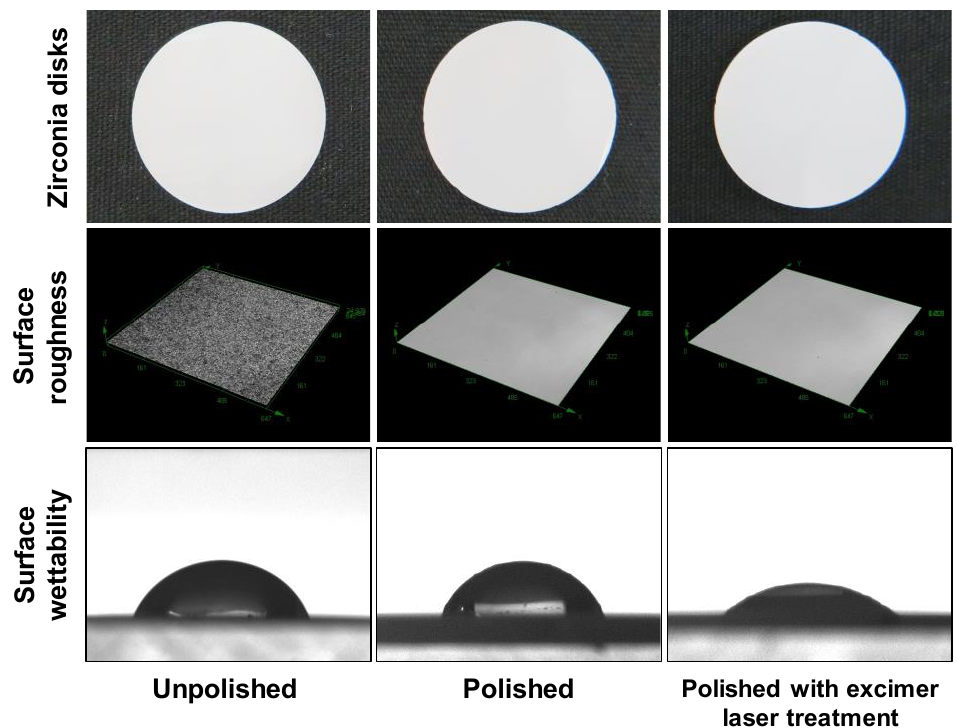
Figure 1. Surface roughness and surface wettability of zirconia disks. Macroscopically, there was no difference in the surface properties of the zirconia discs. In a 3D measuring laser microscope, the surface texture was smoother in the polished disks compared to the unpolished disks, but there was no difference in surface texture between the polished disks with or without the excimer laser treatment. There was no difference in surface wettability between the unpolished and polished disks, but the polished disks with the excimer laser treatment had an improved surface wettability compared to the polished disks without the excimer laser treatment.